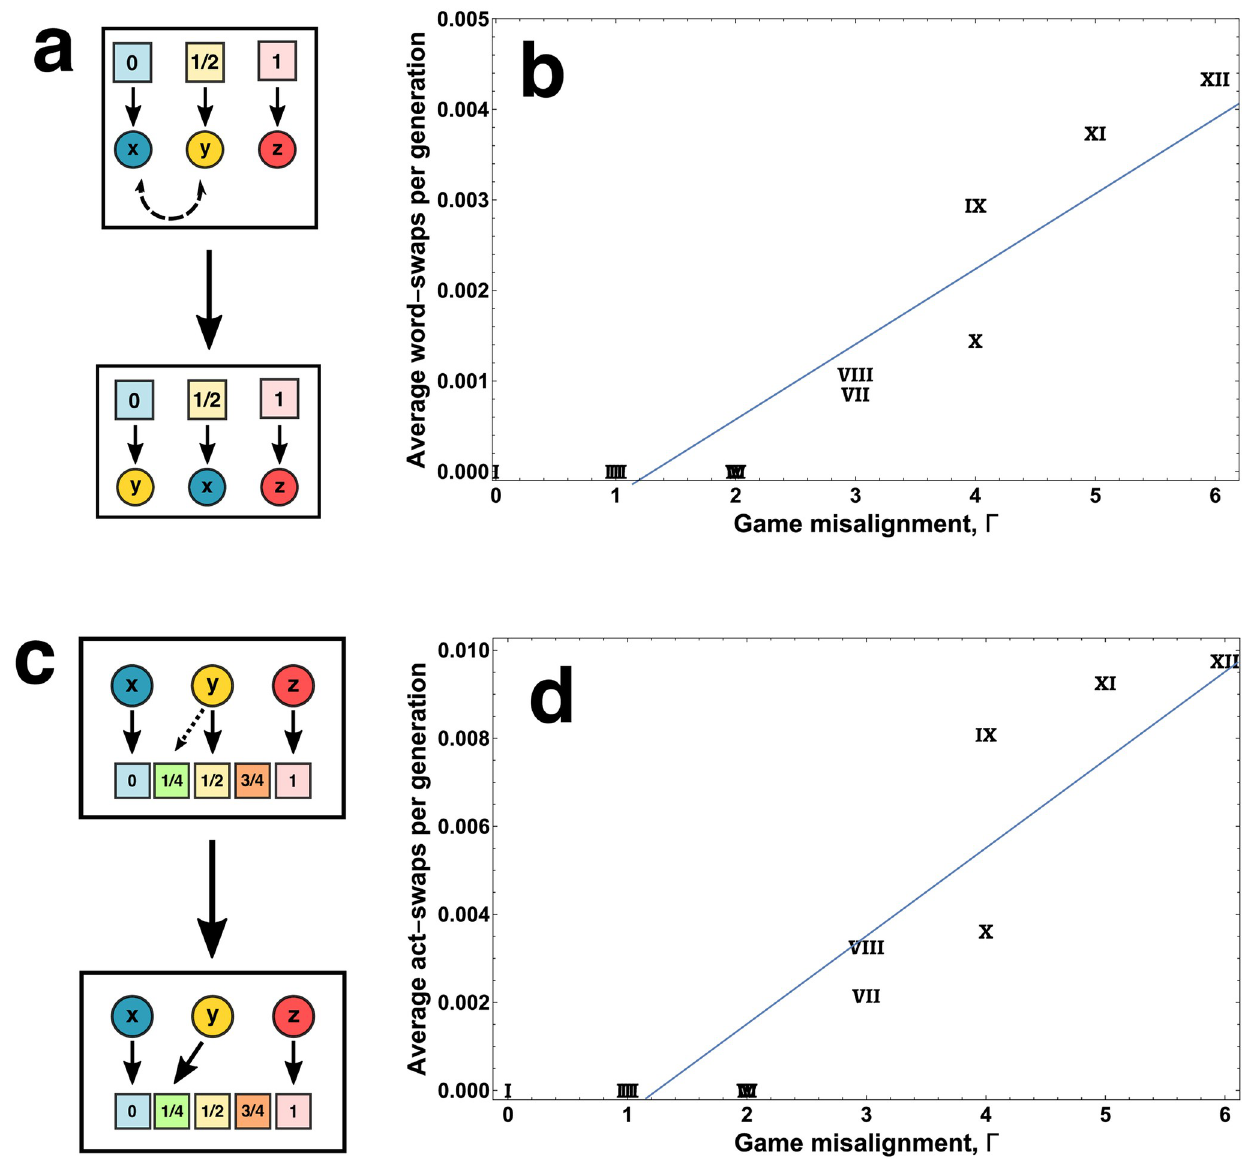
Fig 3. Meanings often change over time due to misaligned interests. ( a ): Changes in the speakers’ perception of their lexica. In each generation, we keep track of whether or not the most probable word used for a state among the population changes (swaps). Tallying the number of swaps gives one measure of change in lexical meaning over time. Note that while a word can be most probable for more than one state, we require a swap lead to changing in the overall strategic ranking of available words in the eyes of the population of speakers ( b ): The average number of word-swaps per generation in all twelve games, with k = 100 and μ = 0.001. The blue line denotes a linear best-fit. ( c ): Changes in the listeners’ perception of their lexica. Similar to ( a ), we tally the number of changes in the most probable action for the listeners in response to a word. However, unlike in ( a ), here we measure simply the steps (in Hamming distance) between the previous and current generation. ( d ): The average number of action swaps per generation in all twelve games, with k = 100 and μ = 0.001. The blue line denotes a linear best-fit. All panels here are for the asymmetric game, but the symmetric game has nearly identical results, see Fig H in S1 File. The overlapping game symbols for Γ = 1 are II,III , and for Γ = 2 are IV,V,VI